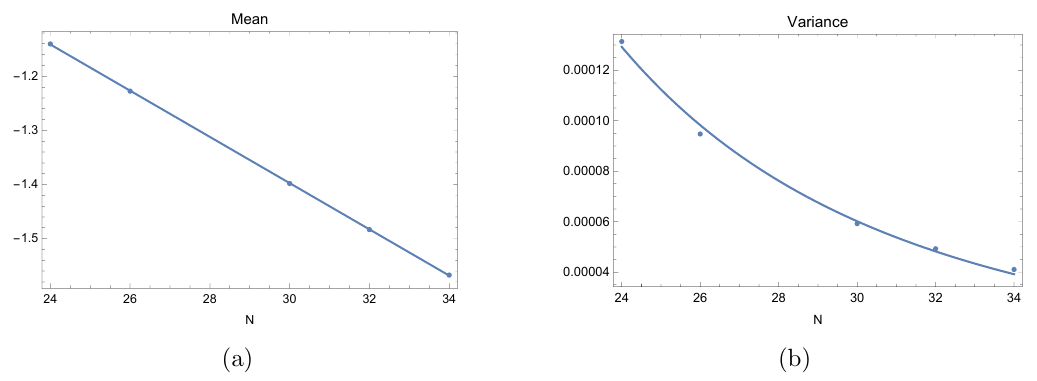
Figure 5. Ground state mean and variance as a function of N , computed over 10 4 realizations for each value of N . (a) The mean ground state energy, with a linear (cid:12)t to h E 0 i = (cid:0) 0 : 043 N (cid:0) 0 : 12. (b) The variance of the ground state energy, with a power-law (cid:12)t to Var( E 0 ) (cid:24) N (cid:0) 3 : 43